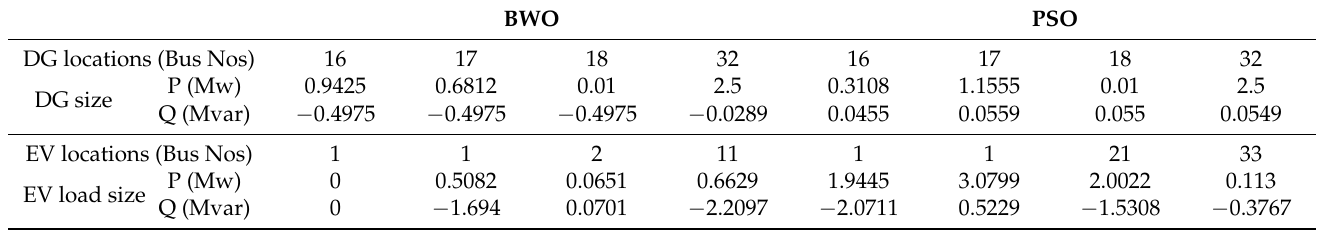
Table 2. Comparison of BWO with PSO.